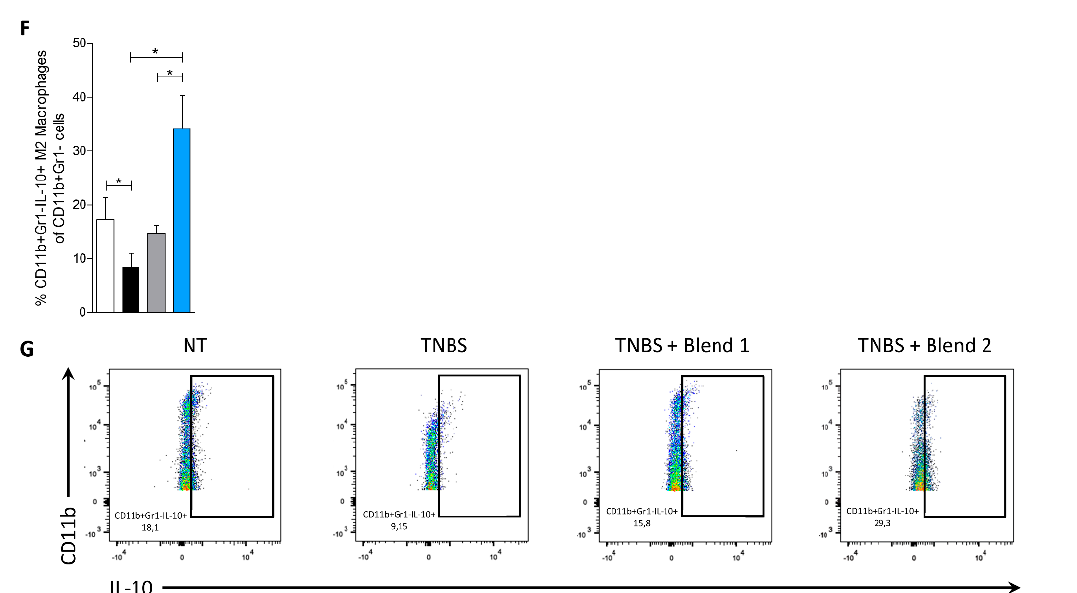
Figure 4. Effect of probiotics on the immune phenotype of colonic lamina propria cells in the model of colitis induced by dextran sulfate sodium (DSS). The experiment was carried out on Balb/c mice. Mice were treated with DSS in drinking water and then administered with vehicle or one of the two formulations of probiotics by gavage from day 0 to day 8. Frequency of immune cells in the colonic lamina propria : CD4+ cells ( A ), CD4+FoxP3+ cells ( B , D ), and CD4+IL-10+ cells ( C ). ( E ) Flow cytometry analysis of IL-10 expression and FoxP3 expression in CD4+ cell recruited into the lamina propria . ( F ) Frequency of CD11b+Gr1-IL-10+ M2 macrophages in the colonic lamina propria . ( G ) Flow cytometry analysis of Il-10 expression in CD11b+Gr1- macrophages recruited into the lamina propria . Results are the mean ± SEM of 6–10 mice per group. * p < 0.05. FoxP3, Forkhead box P3. Other abbreviations are listed in Figure